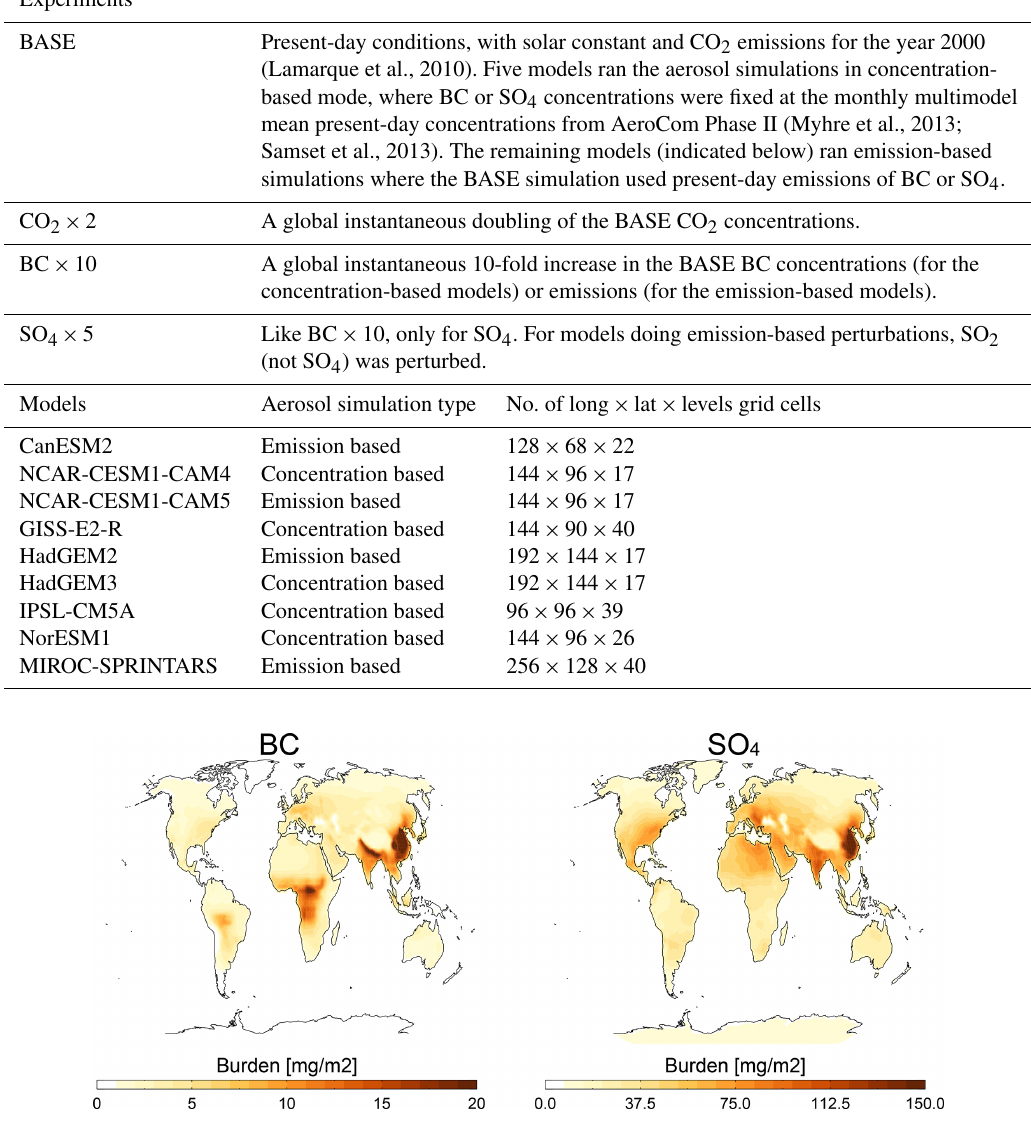
Figure 1. Geographical distribution of the baseline burden of BC and SO 4 , as used in the BASE simulations, and as multiplied by 10 and 5 in the BC × 10 and SO 4 × 5 simulations,